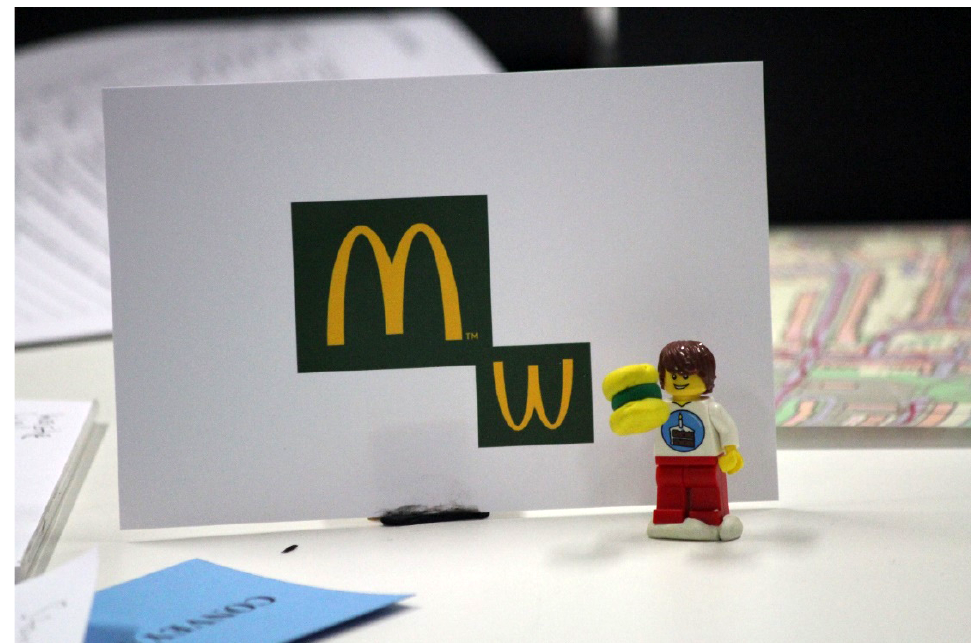
Figure 4. “McWorm” scenario. Photograph by Danielle